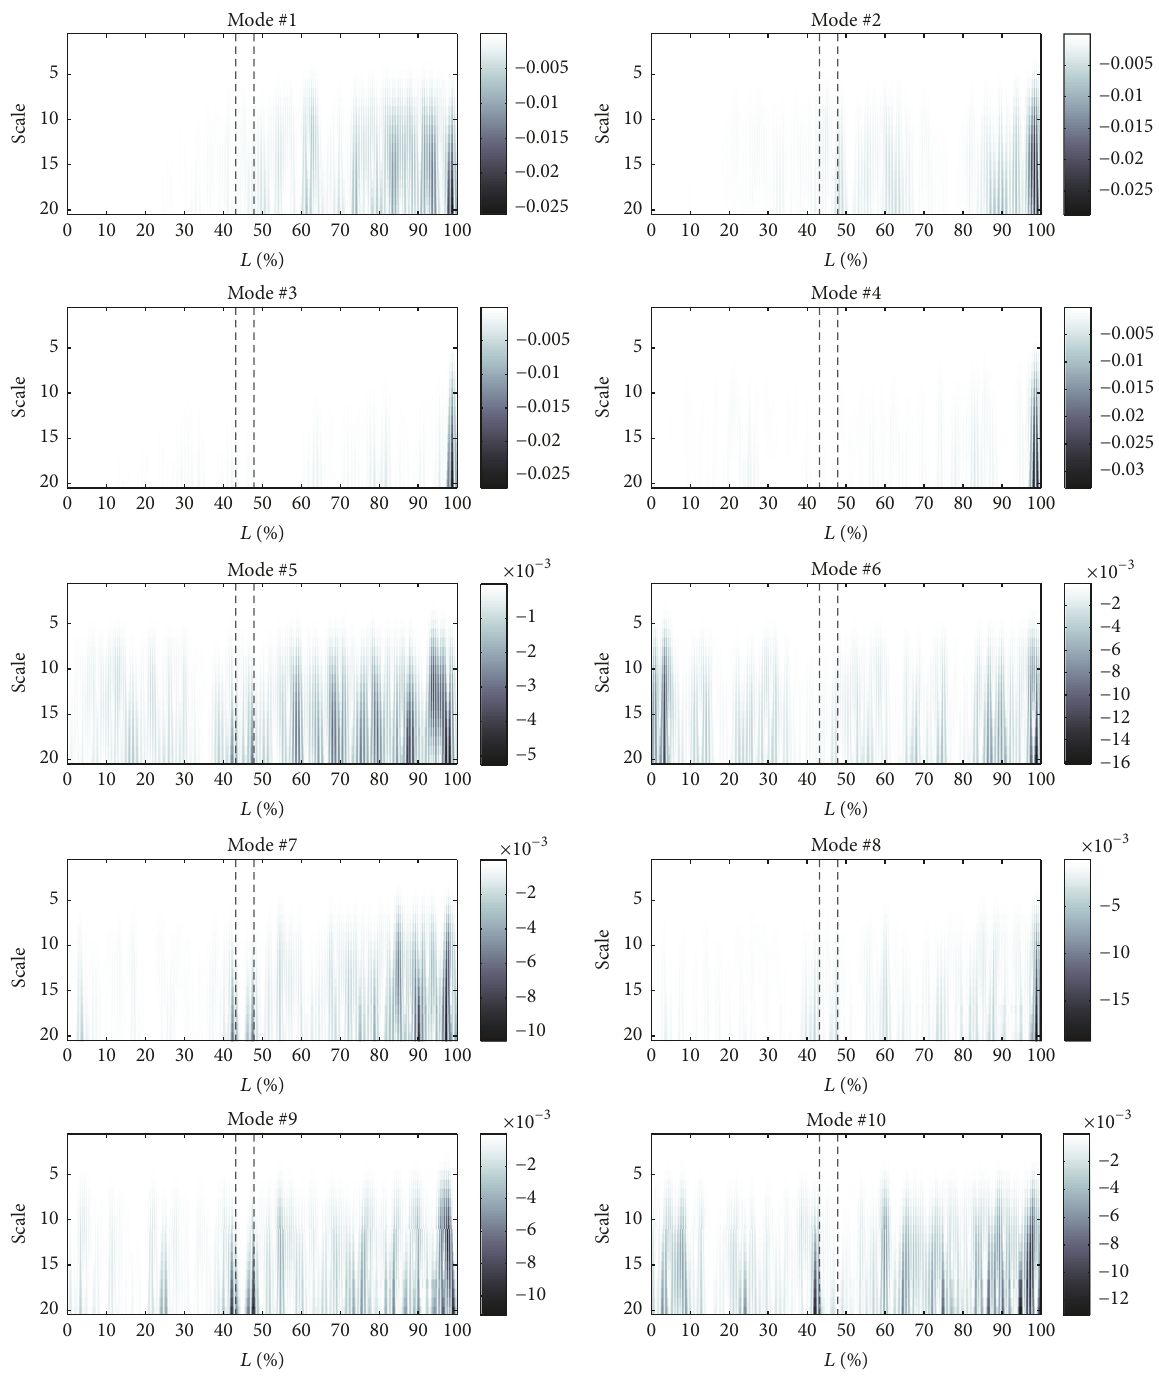
Figure 16: Scalograms obtained from measured data in the case of all modes of natural vibrations.